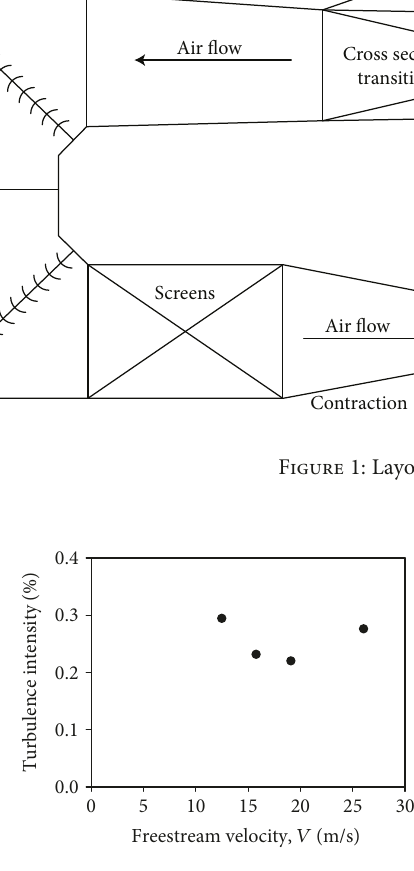
Figure 2: Turbulence intensity level at the wind-tunnel test